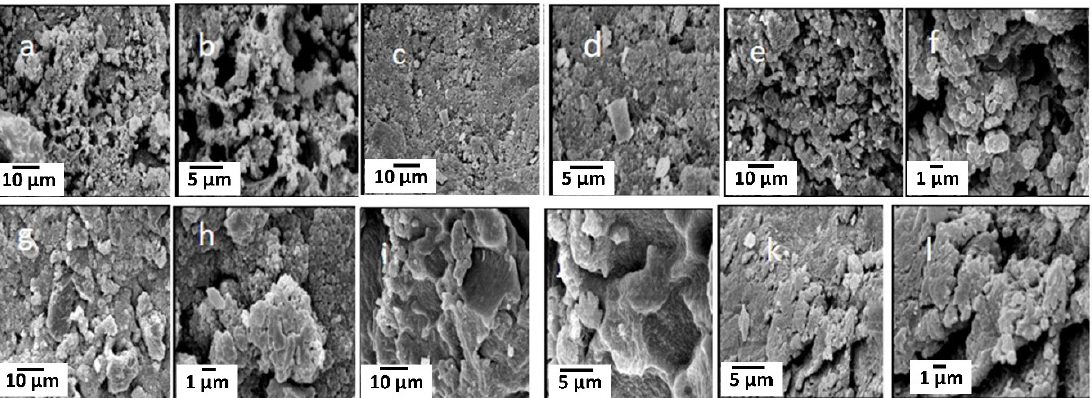
Figure 1. SEM images of polyamide surface at different magnifications; P1a ( a ) X = 2000, ( b ) X = 5000; P1c ( c ) X = 2000, ( d ) X = 5000; P2a ( e ) X = 2000, ( f ) X = 10,000; P2c ( g ) X = 2000, ( h ) X = 10,000; P3a ( i ) X = 2000, ( j ) X =5000; P3d ( k ) X = 5000, ( l ) X = 10,000.